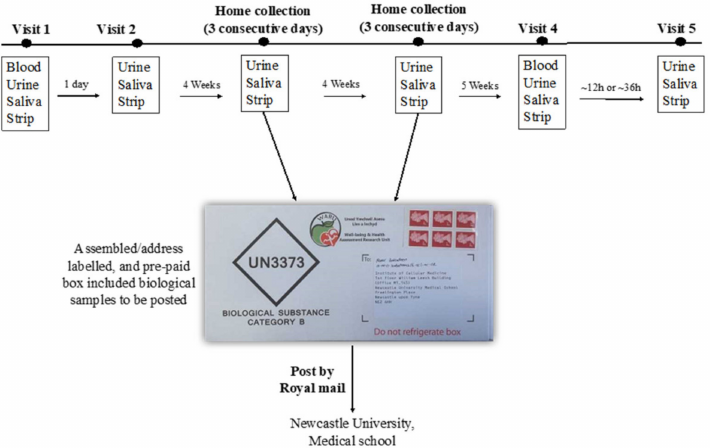
Figure 1. Summary of the collection of biological samples during the study. Urine collection kit used is (Biological substance Category B, Shuttlepac,